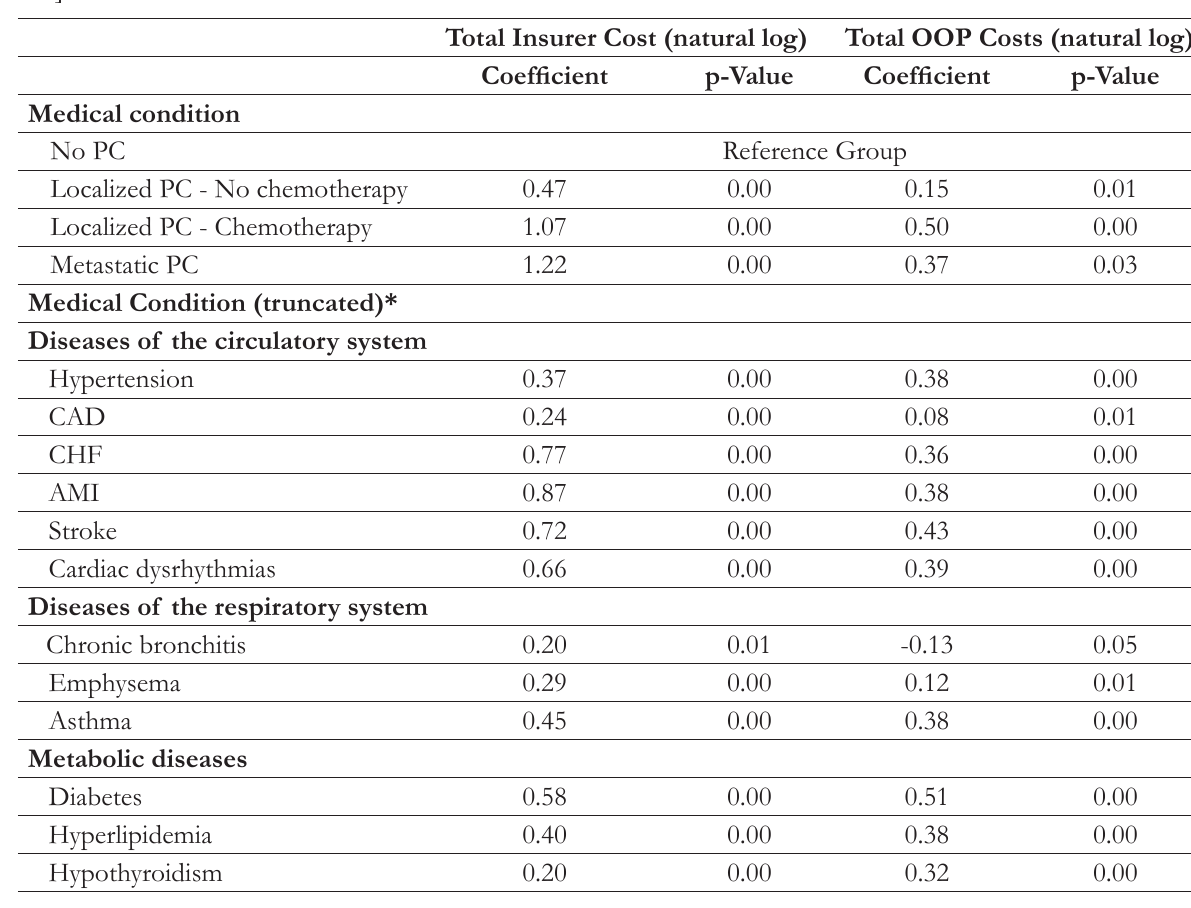
Table 4. Ordinary Least Squares of Total Healthcare Insurer Expenditures and Total OOP Expenditures